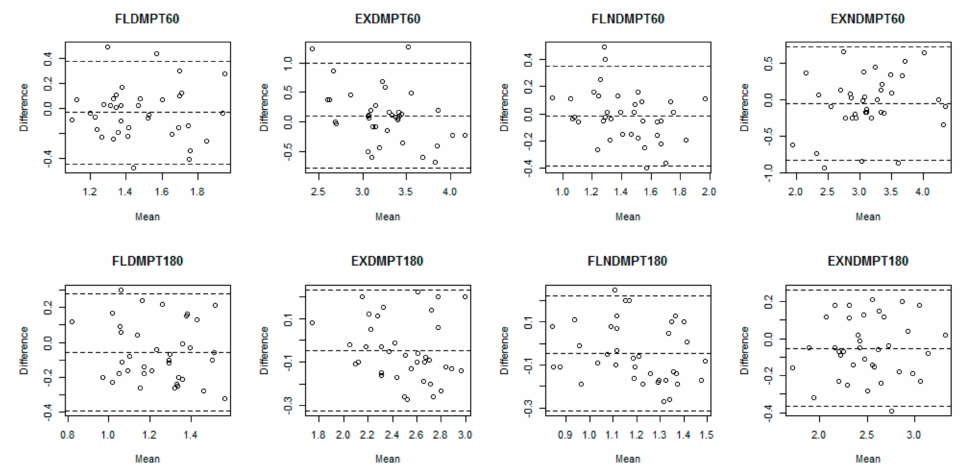
Figure 2. Bland–Altman plots for the intra-rater reliability of the new dynamometer based on the mean of two trials in eight measures. The first dashed line represents Mean–1.96 × SD, the second dashed line represents Mean, and the third dashed lines represent Mean + 1.96 × SD. The grey circles indicate differences beyond the 95% confidence limits.